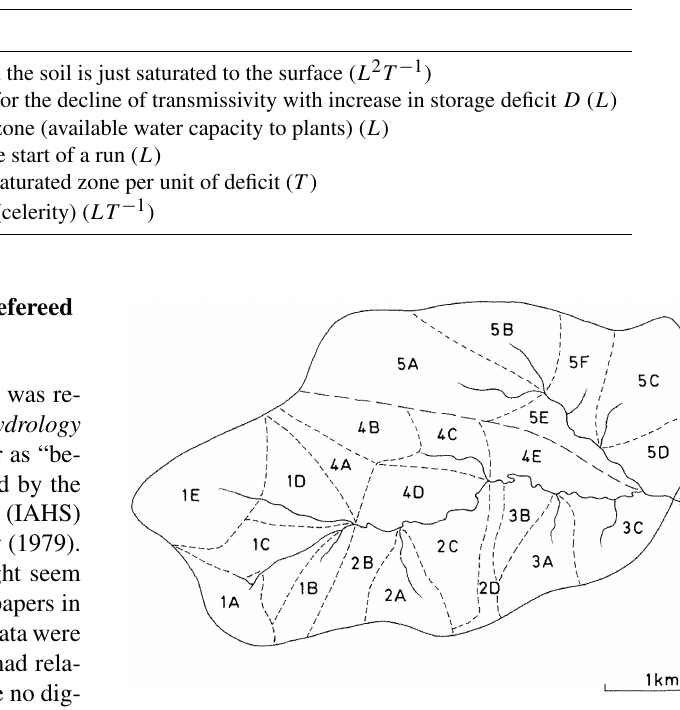
Figure 4. Subdivision of the 8km 2 Crimple Beck catchment, York- shire, UK, into 23 headwater and side-slope subcatchments (from Beven and Kirkby, 1979, with permission from Taylor and